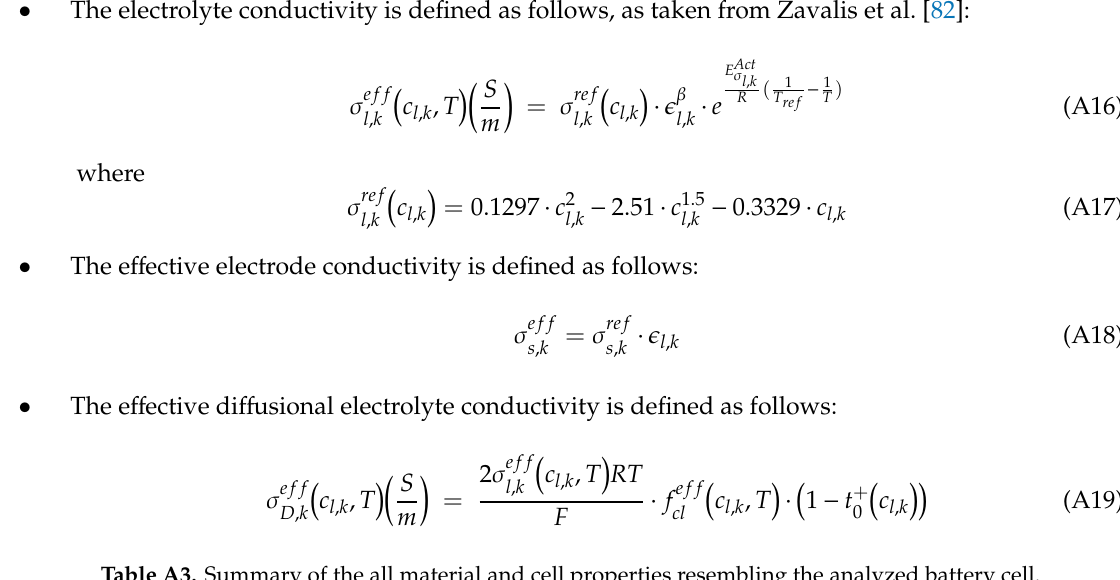
Table A3. Summary of the all material and cell properties resembling the analyzed battery cell. Meaning Symbol Unit